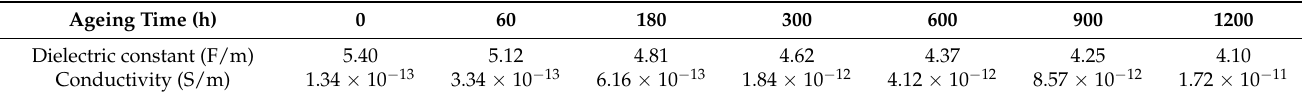
Table 1. Dielectric constant and conductivity of epoxy resin coating under different ageing time.